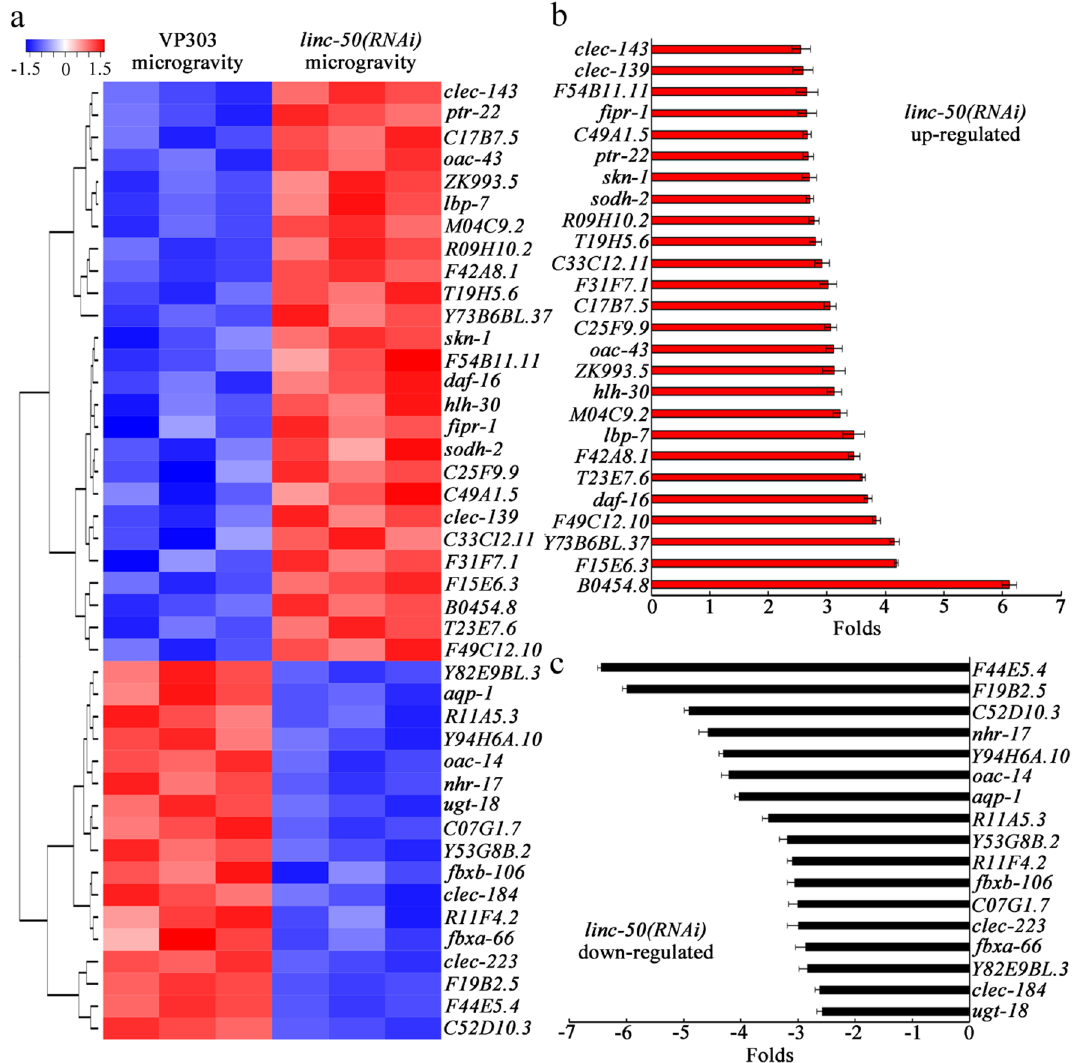
Figure 4. Identification of dysregulated genes by intestine-specific RNAi knockdown of linc-50 in simulated microgravity treated nematodes. ( a ) Heatmap showing expression of dysregulated genes in simulated microgravity treated nematodes with intestine-specific RNAi knockdown of linc-50 . The heatmap was drawn using Omicshare (www.omics hare.com/tools /), a free access online analysis tool of bioinformatics. ( b ) Upregulated genes induced by intestine-specific RNAi knockdown of linc-50 in simulated microgravity treated nematodes. N = 3. ( c ) Downregulated genes induced by intestine-specific RNAi knockdown of linc-50 in simulated microgravity treated nematodes. N = 3. Simulated microgravity treatment was performed in RCCS system at 30 rpm for 24 down of linc-13, linc-14 , or linc-50 suppressed the ROS production in simulated microgravity treated VP303 nematodes (Fig. 3; Table S6), suggesting the resistance to toxicity of simulated microgravity in animals with intestinal RNAi knockdown of linc-13, linc-14 , or linc-50 . Data on efficiency for RNAi knockdown of linc-2 , linc- 13 , linc-14 , linc-50 , or linc-61 in the intestine is shown in Fig. S3 and Table S5. Identification of dysregulated genes induced by intestine‑specific RNAi knockdown of linc-50 in simulated microgravity treated nematodes. We next focused on the identification of downstream genes of linc-50 , one of the candidate lncRNAs whose RNAi knockdown induced a resistance to toxicity of simulated microgravity. Based on HiSeq 2000 sequencing, 43 genes were dysregulated by intestine-specific RNAi knockdown of linc-50 in nematodes treated with simulated microgravity for 24 h (Fig. 4a; Table S7). Meanwhile, expressions of these 43 genes were also affected by simulated microgravity treatment (Table S8). Among these 43 genes, after simulated microgravity treatment, 26 genes ( clec-143 , clec-139 , F54B11.11 , fipr-1 , C49A1.5 , ptr-22 , skn-1 , sodh-2 , R09H10.2 , T19H5.6 , C33C12.11 , F31F7.1 , C17B7.5 , C25F9.9 , oac-43 , ZK993.5 , hlh-30 , M04C9.2 ,